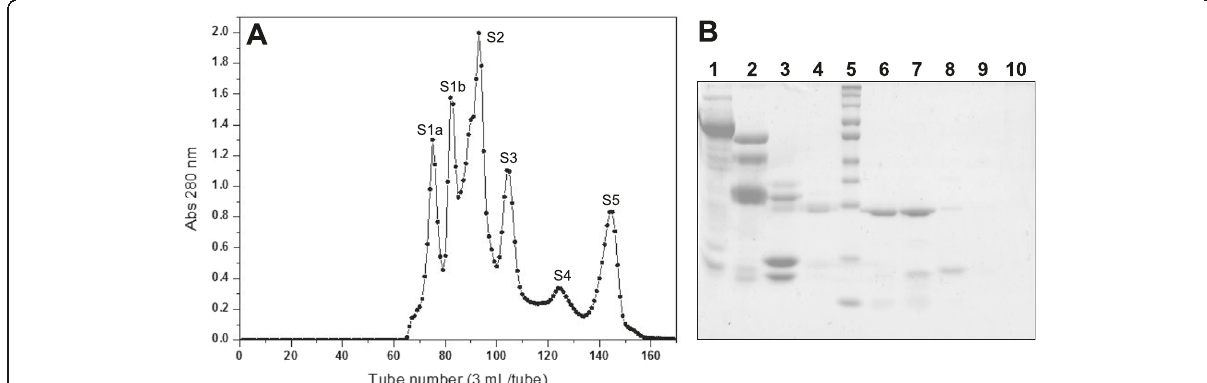
Fig. 1 a Chromatographic profile of the crude venom of B. atrox on a Sephacryl S-200 molecular exclusion column. Elution was performed with 0.2 M ammonium bicarbonate buffer (AMBIC), pH 8.0, collecting 3 mL/tube at a flow rate of 20 mL/hour. b 12 % SDS-PAGE. Lanes: 1 – tube